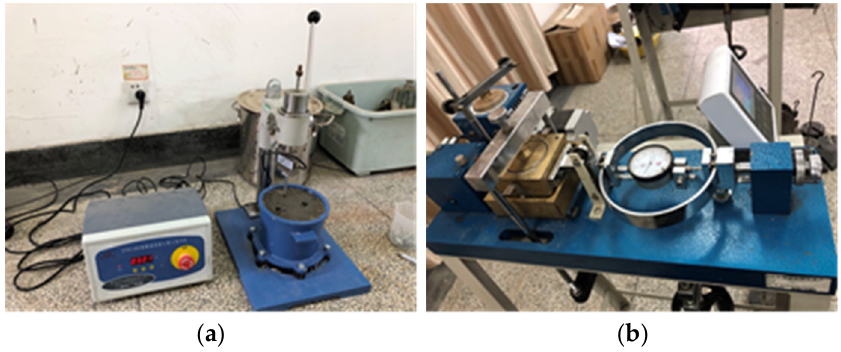
Figure 3. ( a ) Concrete penetration resistance instrument; ( b ) Direct shear instrument.